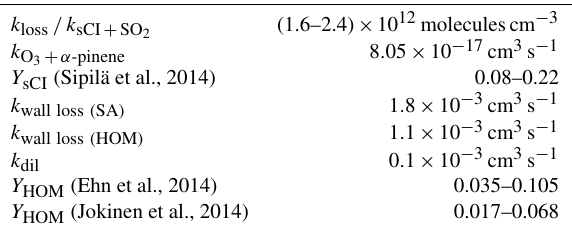
Table 3. Reaction rates, loss terms and yields used in